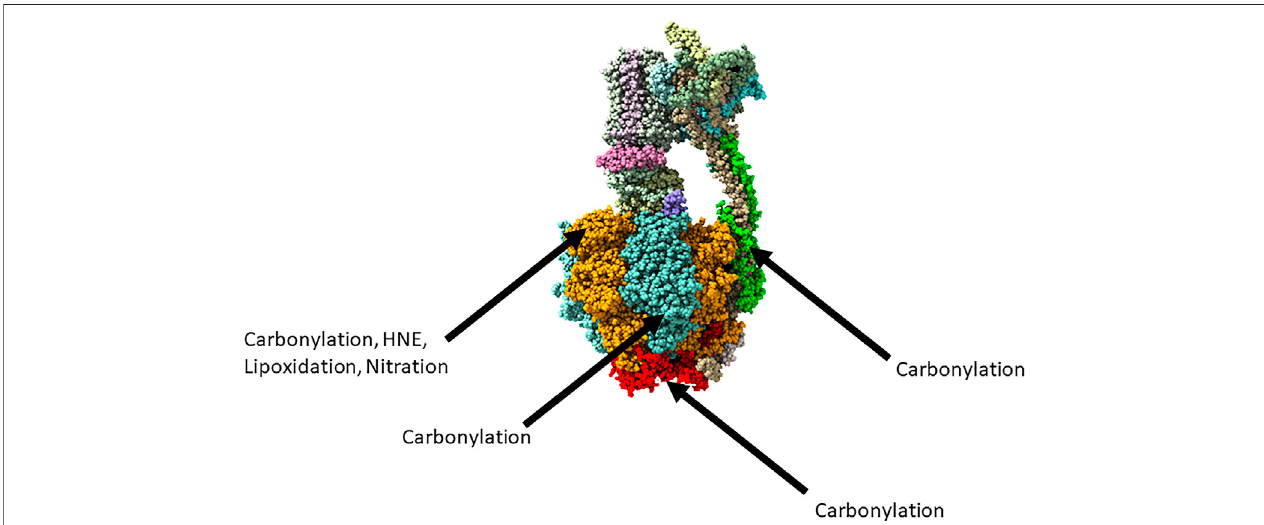
FIGURE 1 | The reported oxidative modi fi cations of ATP synthase in Alzheimer ’ s disease. Adapted from https://www.rcsb.org/structure/6ZPO. Subunit α represented in orange, subunit β represented in blue, subunit O represented in red, subunit D represented in green.